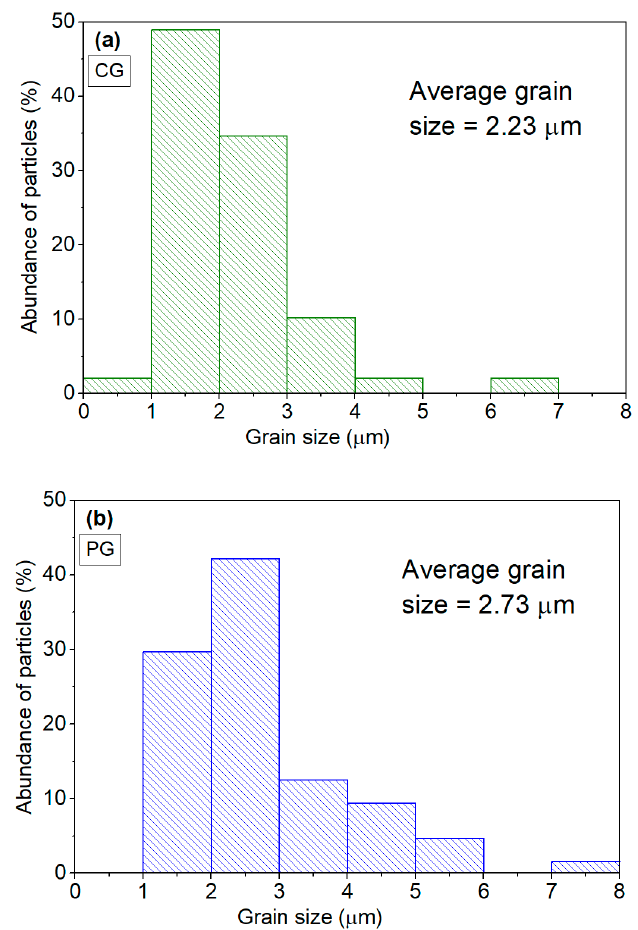
Figure 9. Grain size distribution of the HT 1200 sample prepared via the ( a ) colloidal gel and ( b ) polymeric gel methods.